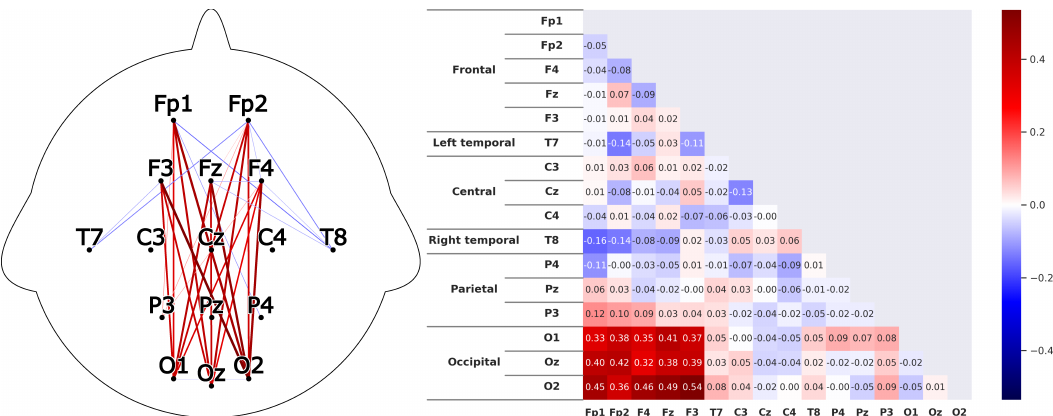
Figure 12. Difference of the results between the HKT leader and the HKT process owner as described in Figure